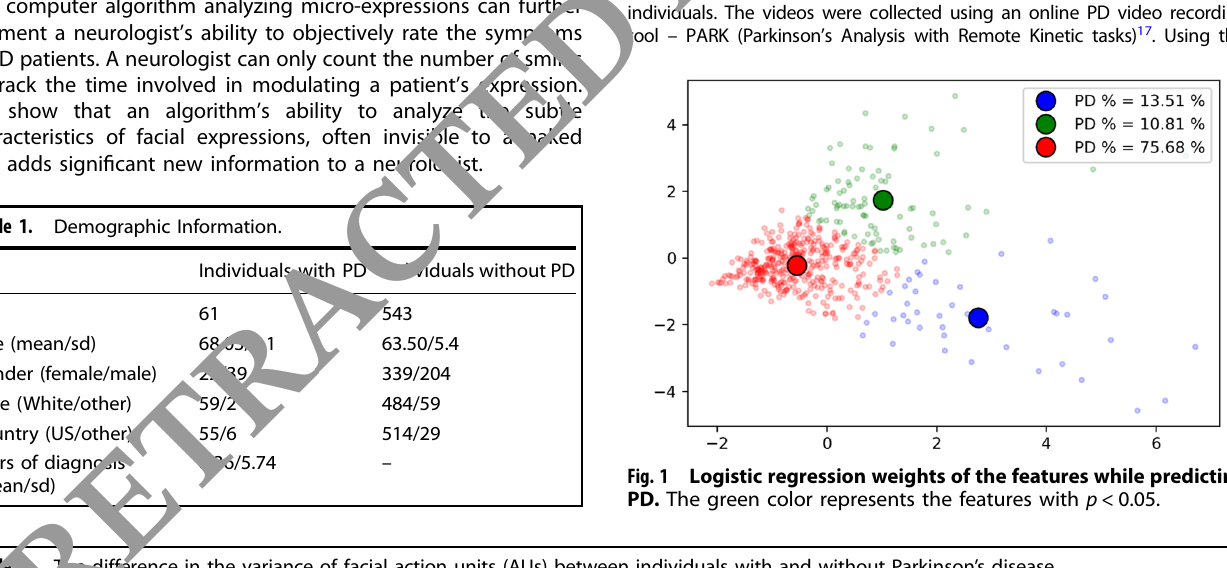
Table 2. The difference in the variance of facial action units (AUs) between individuals with and without Parkinson ’ s disease. Expression Facial action unit